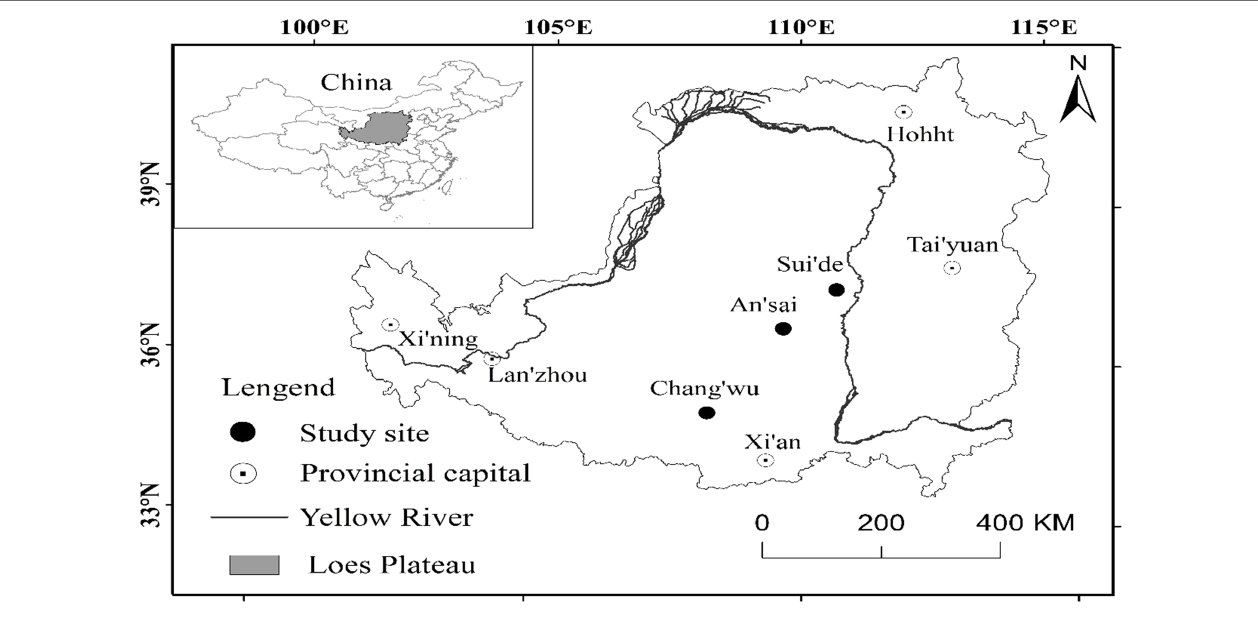
FIGURE 1 | Study sites for locust tree in loess